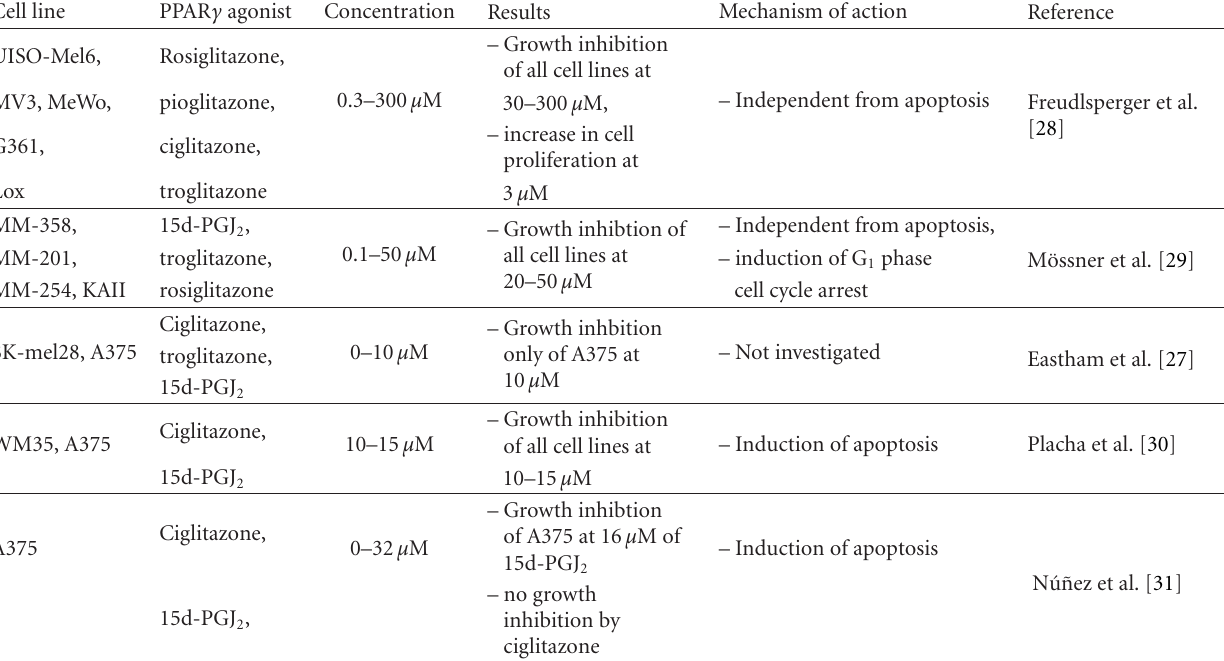
Table 1: E ff ects of PPAR γ agonists on melanoma cell